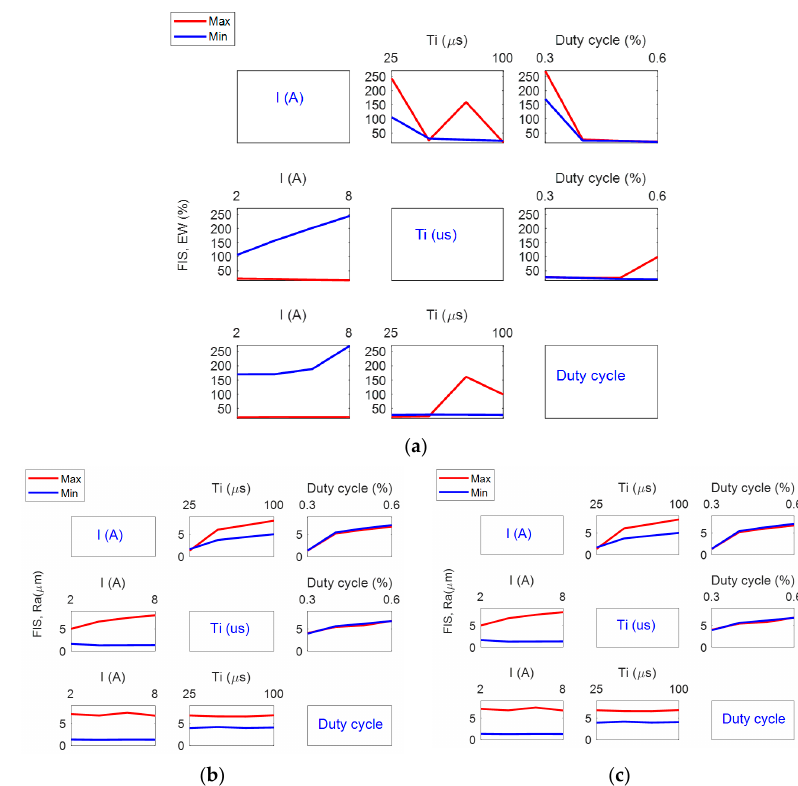
Figure 15. Interaction effects plot for ( a ) EW, ( b ) Ra, and ( c ) MRR in the case of negative polarity, obtained using the FIS.